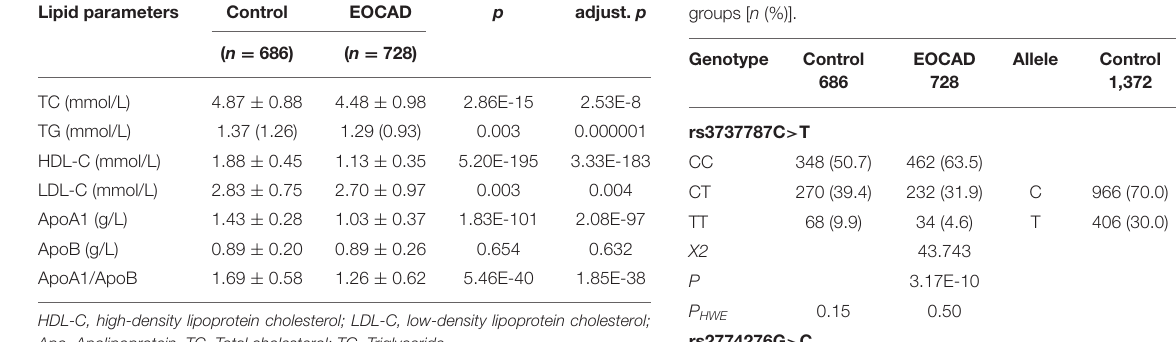
TABLE 3 | Genotype and allele frequencies of the six upstream transcription factor 1 ( USF1 ) single-nucleotide polymorphisms (SNPs) in control and EOCAD groups [ n